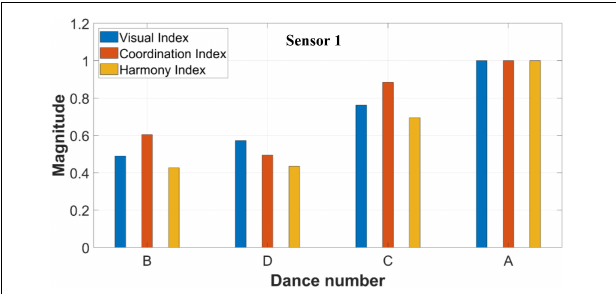
FIGURE 8 | Visual Index, Coordination Index, and Harmony Index generated from sensor 1.